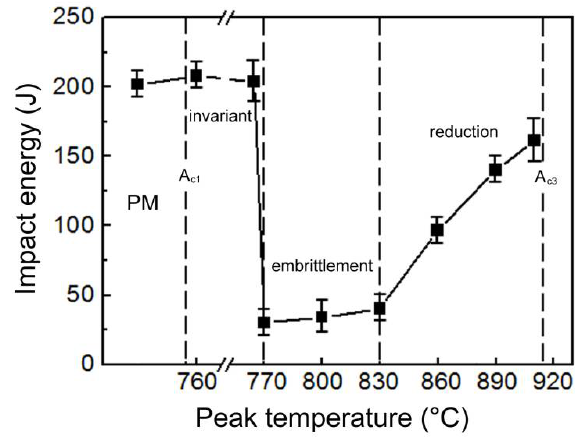
Figure 6. Effect of the peak temperature on the impact toughness of the IC HAZ.